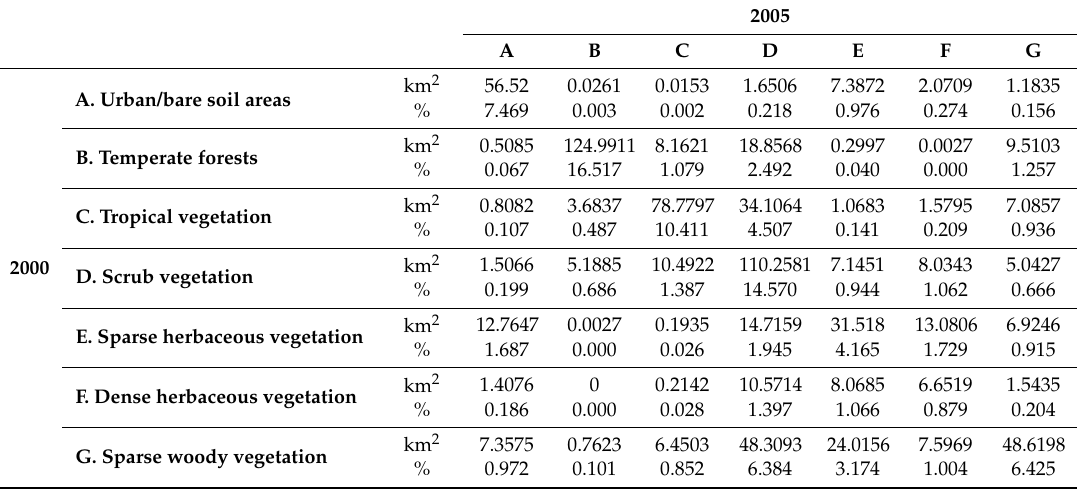
Table 14. Matrix of land use-cover changes from 2000 to 2005, in the adjacent area of Natural Protected Area Altas Cumbres (NPAAC). Victoria, Tamaulipas, Mexico.